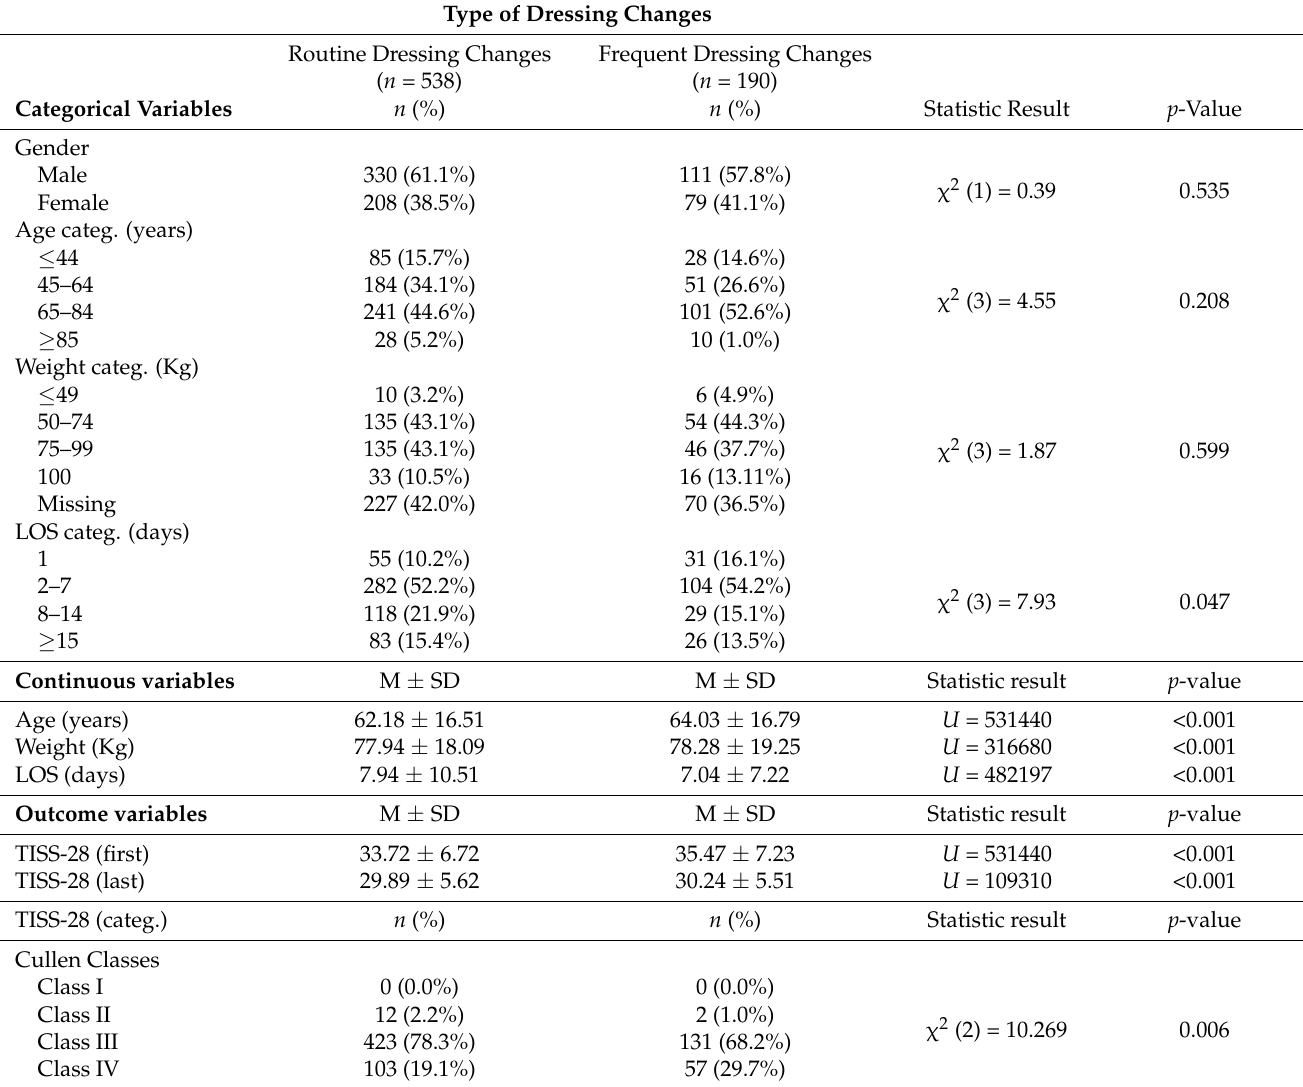
Table 1. Sociodemographic, anthropometric, and clinical characterization of critically ill patients during the period 2015–2019 ( n = 728) by type of dressing